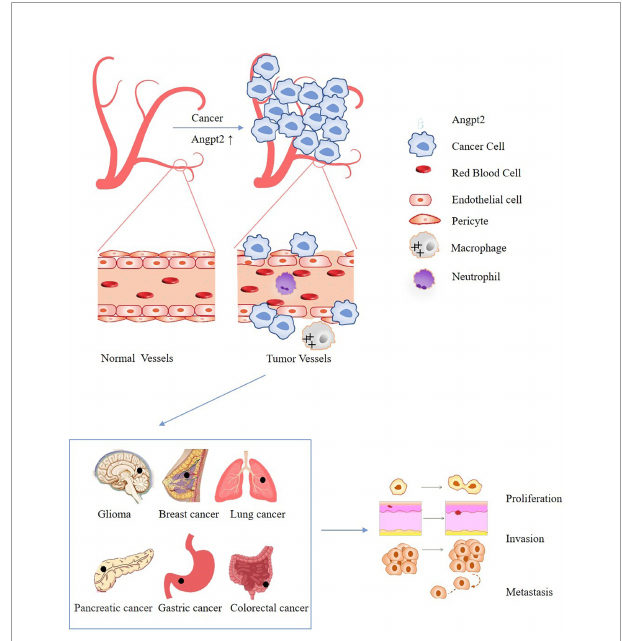
FIGURE 1 | Schematic diagram of the effect of Ang2 dysregulation on cancer cells: The increase of Ang2 in cancer leads to vascular instability, increases leakiness of the vessels, limits immune cell traf fi cking, and fi nally promotes the proliferation, invasion and metastasis of